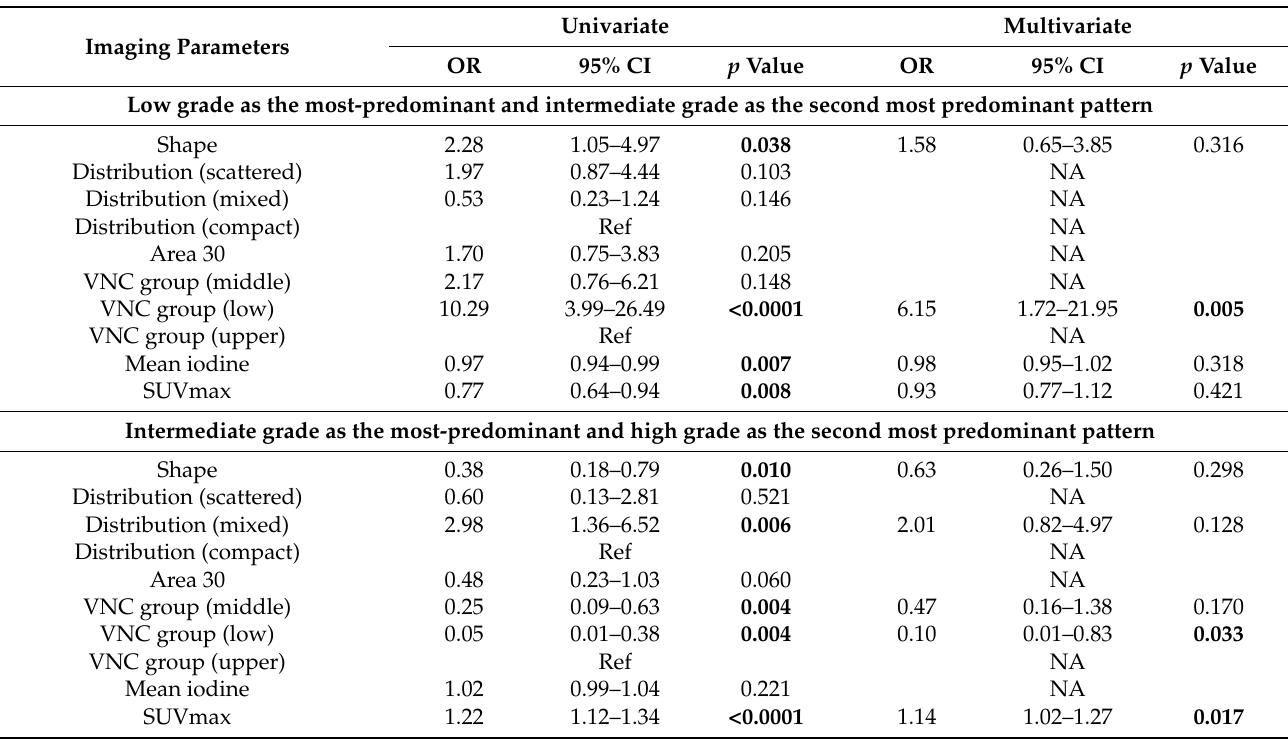
Table 2. Predictors of a histologic combination with non-predominant but higher grade pattern.